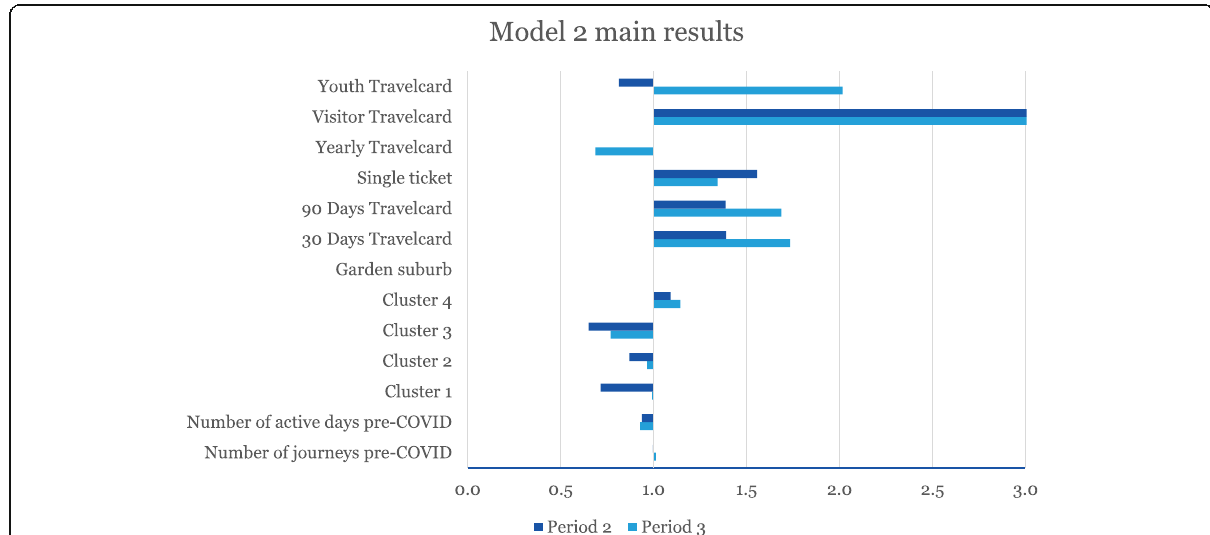
Fig. 5 The main results of Model 2 estimations. The values for Visitor Travel card (8.0 for Period 2 and 7.7 for Period 3) are truncated in order to better represent the other factors used. All parameters are significant at the 5% level, except for the Yearly Travel card for Period 2 and Cluster 1 for Period 3. All factors have small confidence intervals, except the variable for Visitor Travel card for period 2. Note the difference in scale between Figs. 4 and 5. Please see the Additional file 1 for